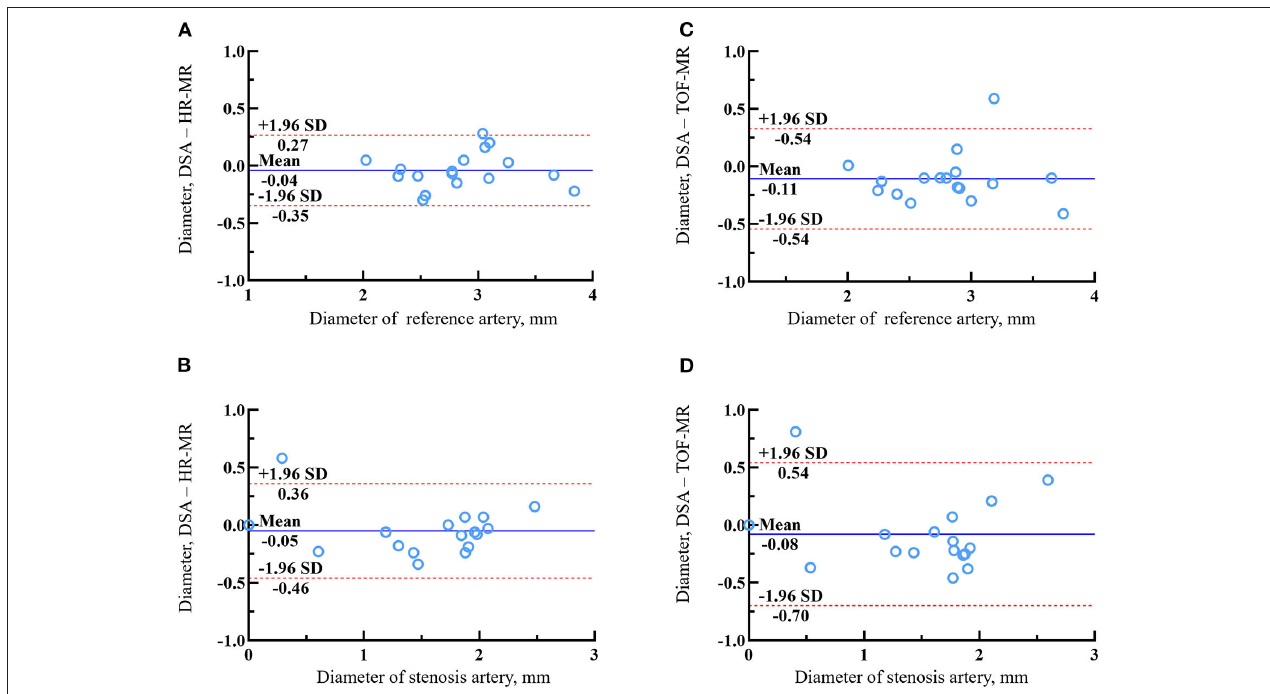
FIGURE 4 | The Bland–Altman plots of lumen diameter measurements of reference artery and stenosis artery between HR-MR images (A,B) or TOF-MR images (C,D) and DSA. The solid lines represent the mean difference and the dashed lines indicate the 95% limits of agreement.